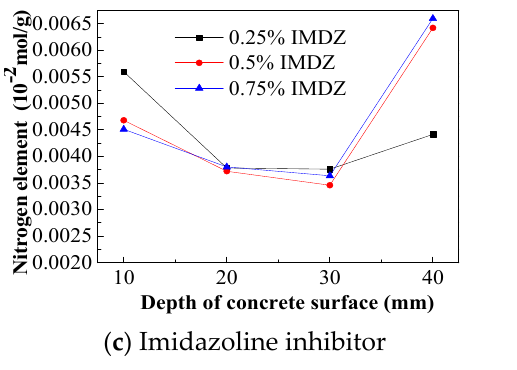
Figure 9. Content of corrosion inhibitor in depth of concrete surface.